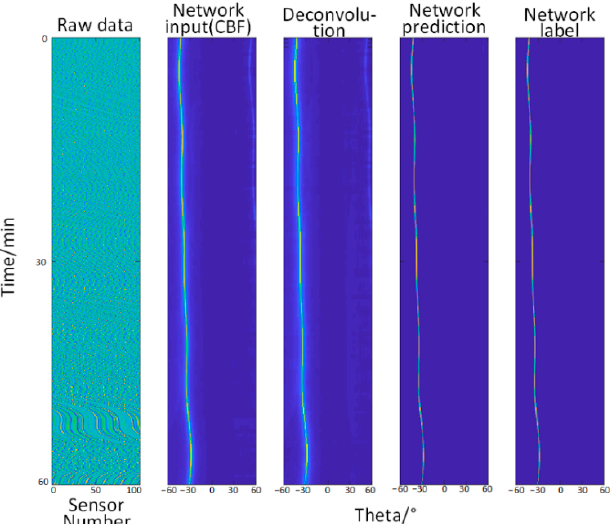
Figure 2. Comparison of angle recognition results by different methods under noise-free conditions, the input of the network (the abscissa is the angle, and the ordinate is the time, which are the same below), deconvolution method, the prediction of the network, and the network label (true trajectory).